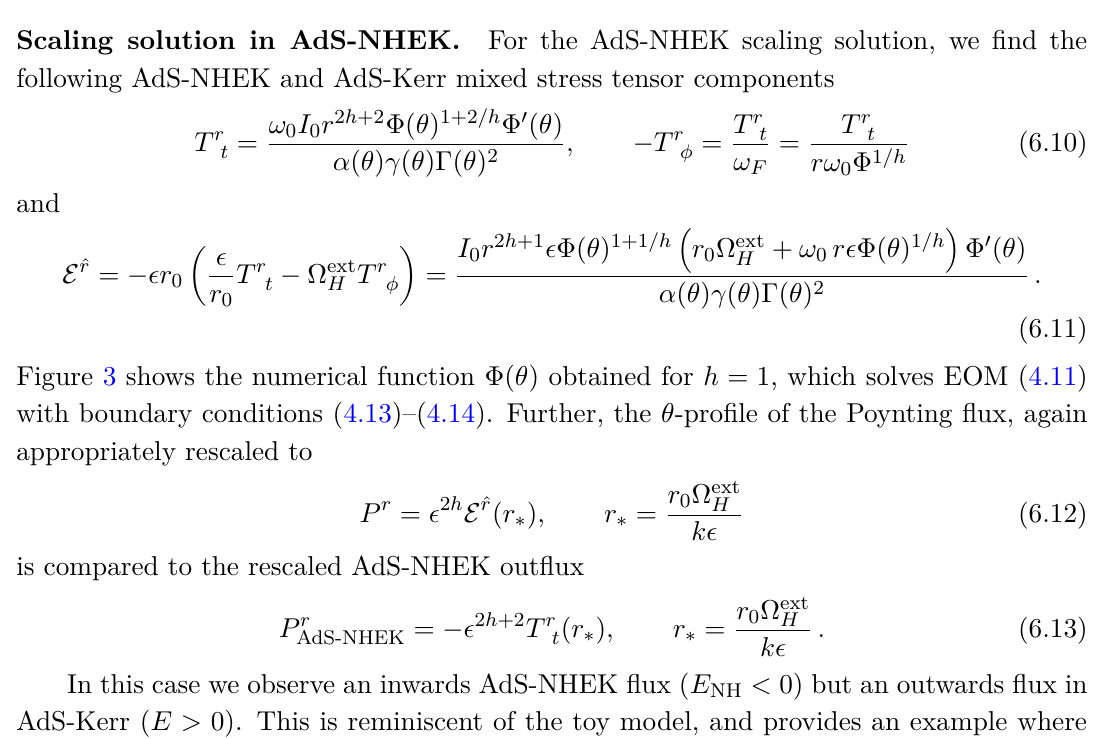
Figure 2 . Solution Φ( θ ) and corresponding Poynting flux P r as a function of θ , for the energy extracting NHEK scaling solution for parameter values ω 0 = − 1 ,h = 1 ,I 0 = 0 . 1 and Ω ext and with Φ( π/ 2) = 1 . 44774 . This reproduces the solution of [14] (up to a sign disagreement). The Kerr flux is smaller than the NHEK